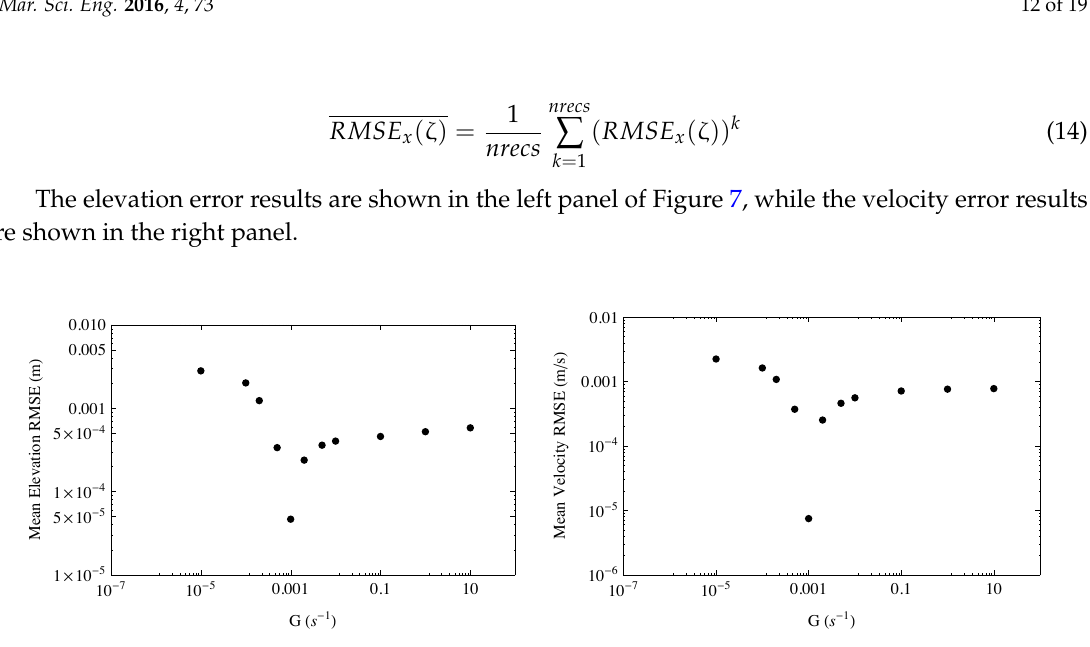
Figure 7. RMSE x ( ζ ) ( left panel ) and RMSE x ( u ) ( right panel ) results, over the last two days of 10.0-day simulation, for simulations with different values of G on the linear sloping domain, using observations from the 2D CG ADCIRC model with G = 0.001 s − 1